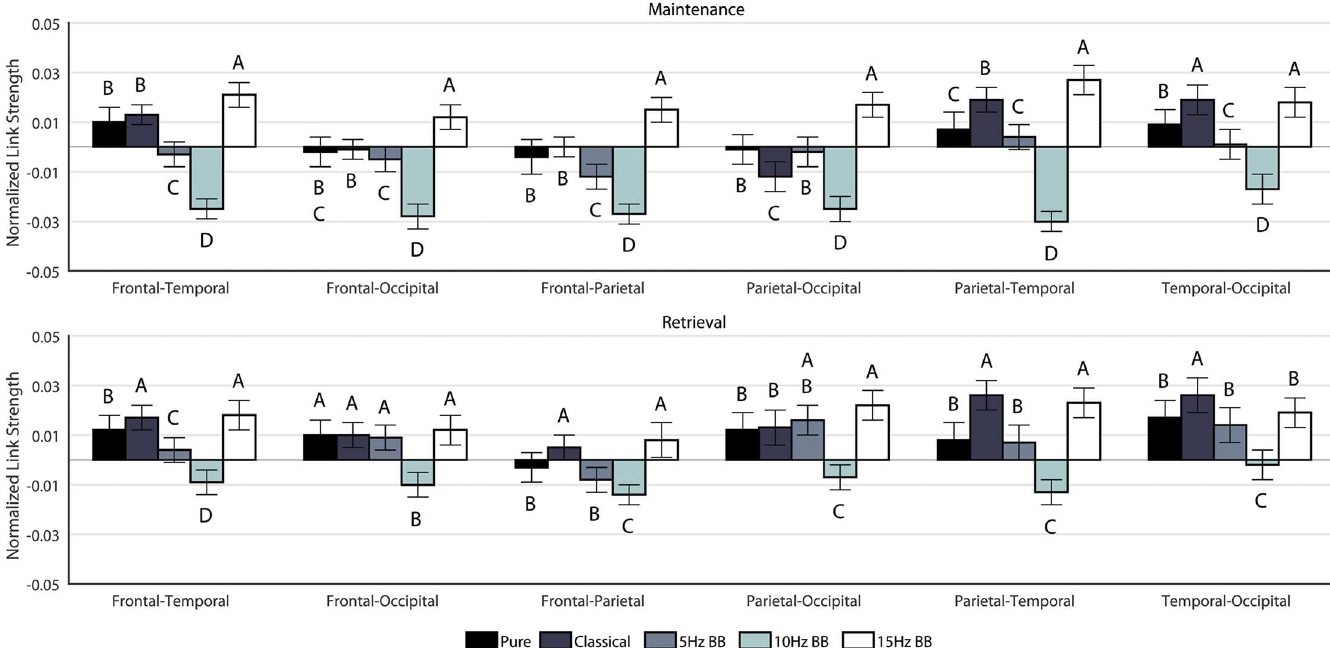
Fig 10. Regional Link Strengths. Each conditionis normalizedagainstNone. The significances are shown for each link individually. Conditions marked with different letters are significantly different.